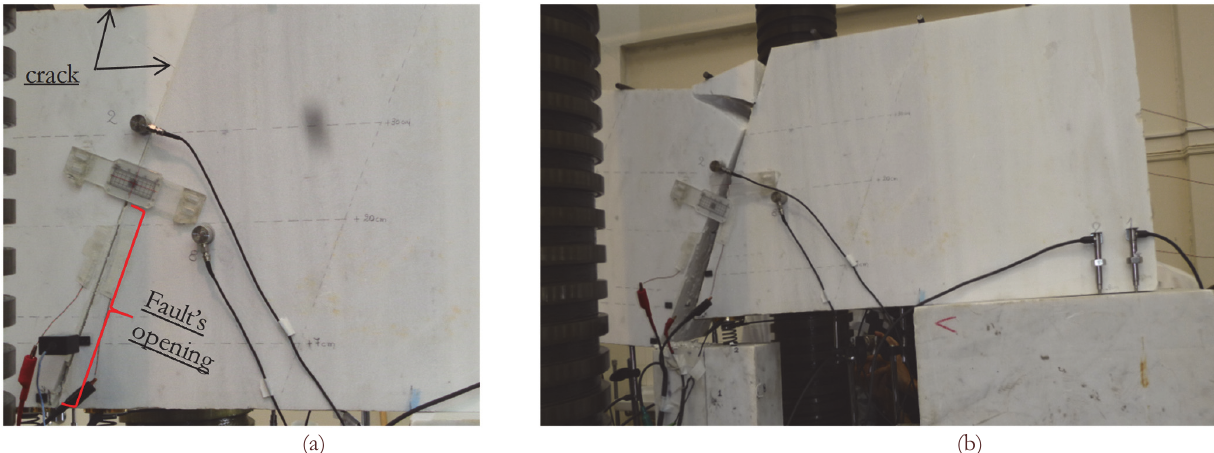
Figure 4: (a) First macroscopically visible cracking of the upper corner of the left fragment at time instant t~1140s. (b) The epistyle after the final failure (fracture of all reinforcing titanium